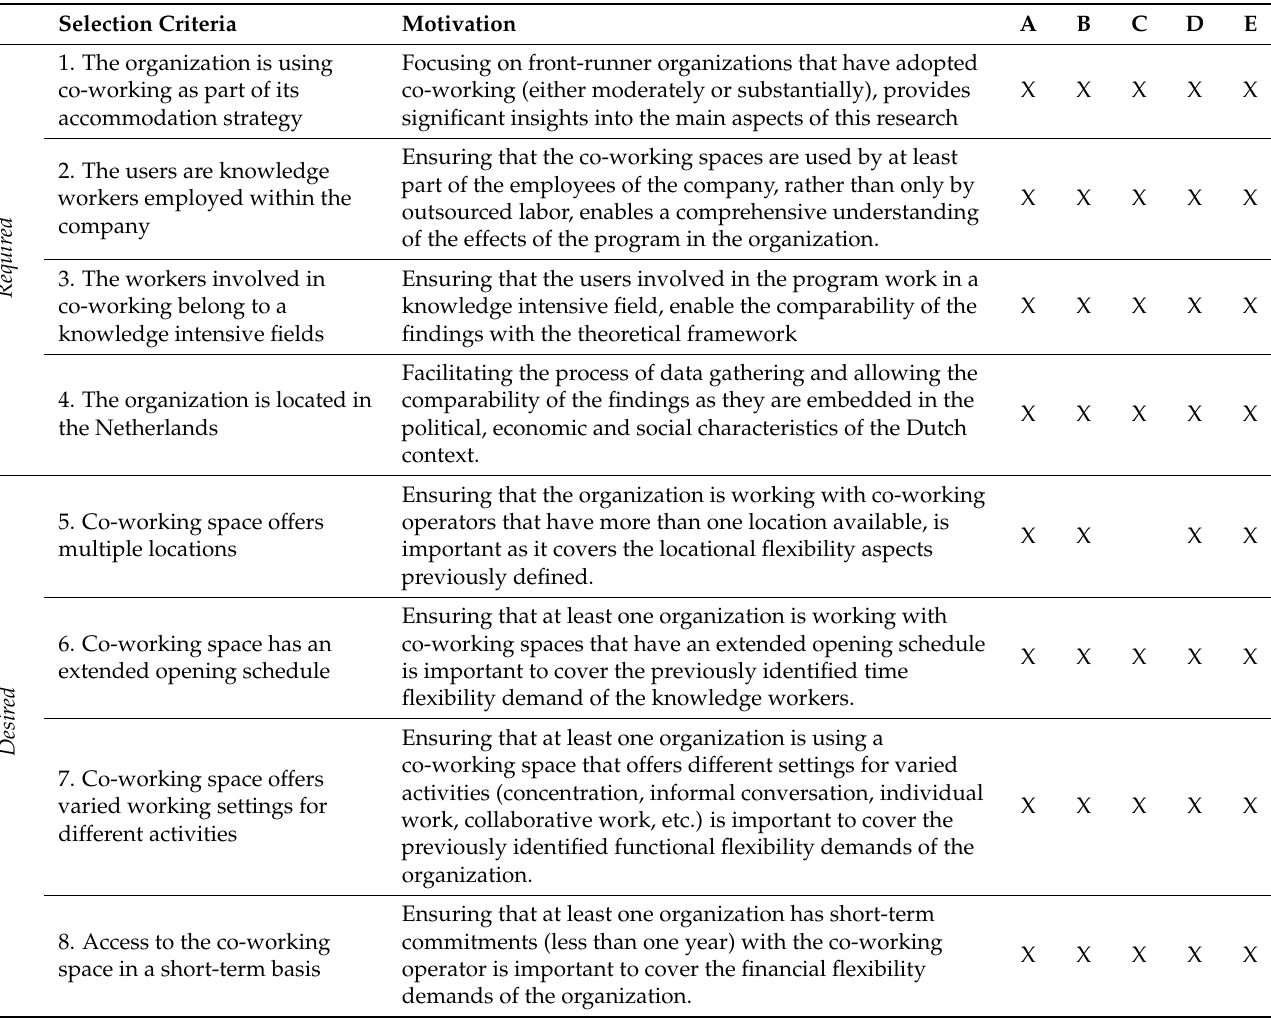
Table 1. Case study selection